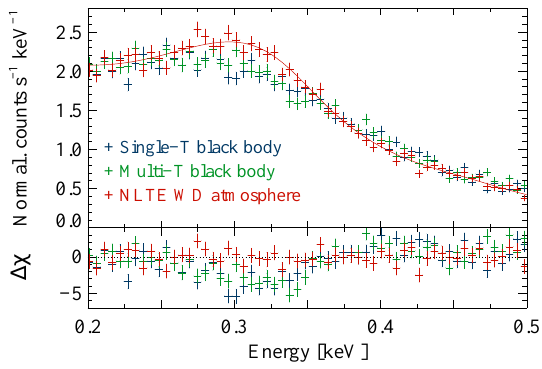
Figure 4: Synthetic spectra of a 50 ks eROSITA pointed observation, based on different models for the heated white dwarf in the X-ray soft polar AI Tri.